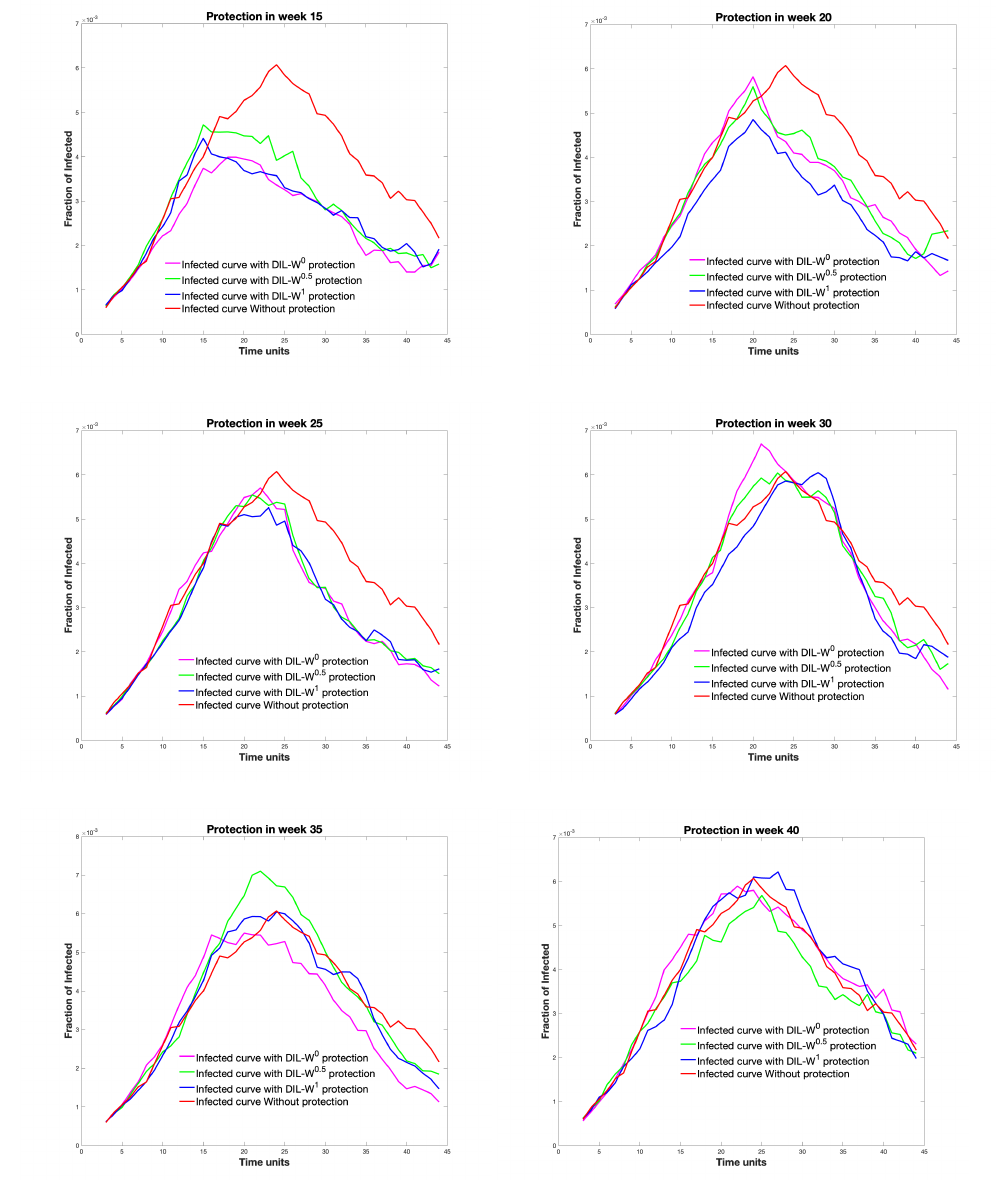
Figure 11. The different infected curves, considering the 10% protection according to the DIL-W α ranking and carried out in different